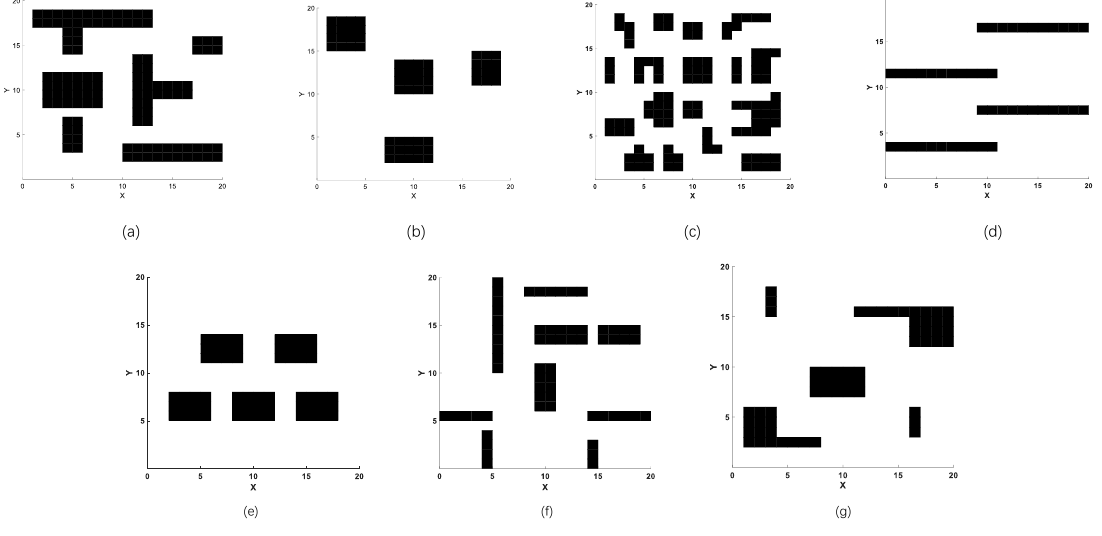
Figure 5. Set of test 20 × 20 maps for the first scenario in which ( a – g ) show the different distributions of obstacles on 20 × 20